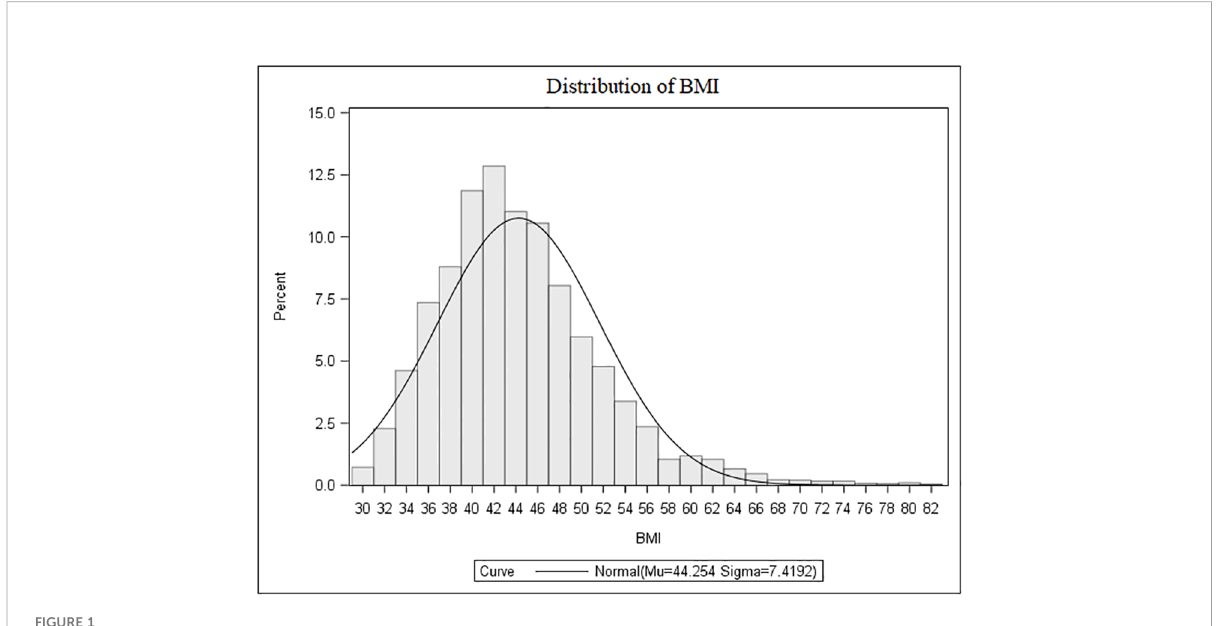
FIGURE 1 Distribution of BMI values in the whole population.